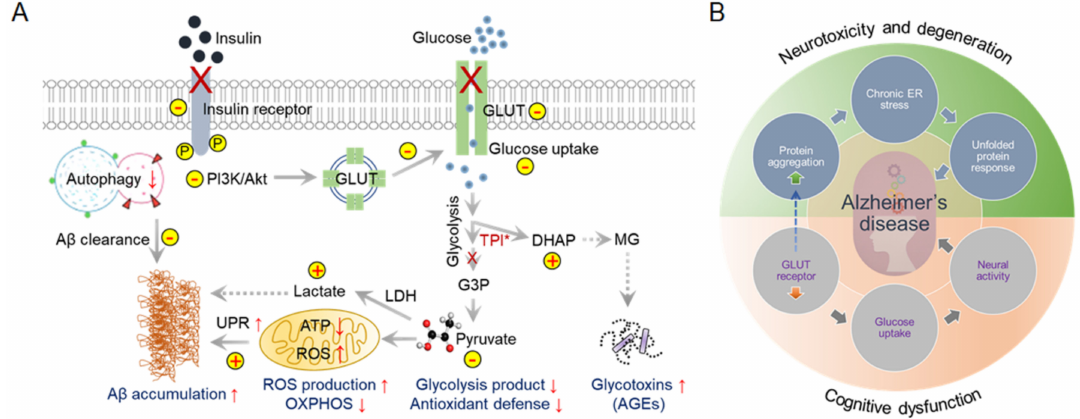
Figure 1. Dysfunctional cerebral glucose metabolism is a crucial factor in AD development. Glucose catabolism in AD is directly connected to further negative consequences in AD syndrome develop- ment. ( A ) Schematic representation of defective glucose metabolism in AD and various outcomes. ↑ arrows indicate upregulation and ↓ arrows indicate downregulation. ( B ) Glucose metabolism forms the bridge between neurotoxicity and cognitive dysfunction in AD. This interconnected Venn diagram describes the scenarios in which AD-related toxicity and cognitive dysfunction appear during AD onset and